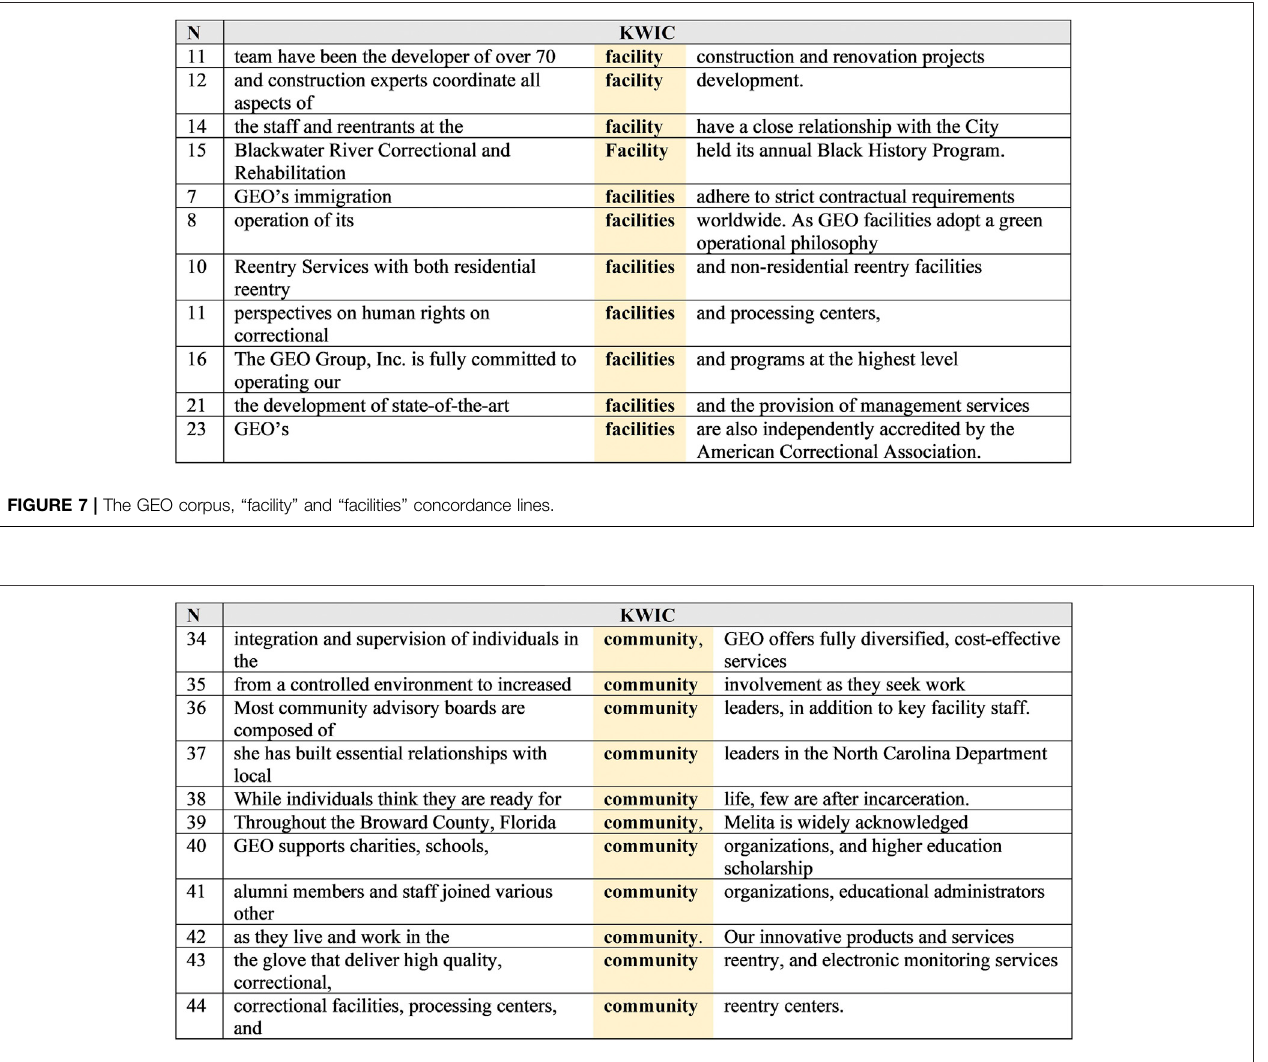
FIGURE 8 | The GEO corpus, “ community ” concordance lines 34 – 44.